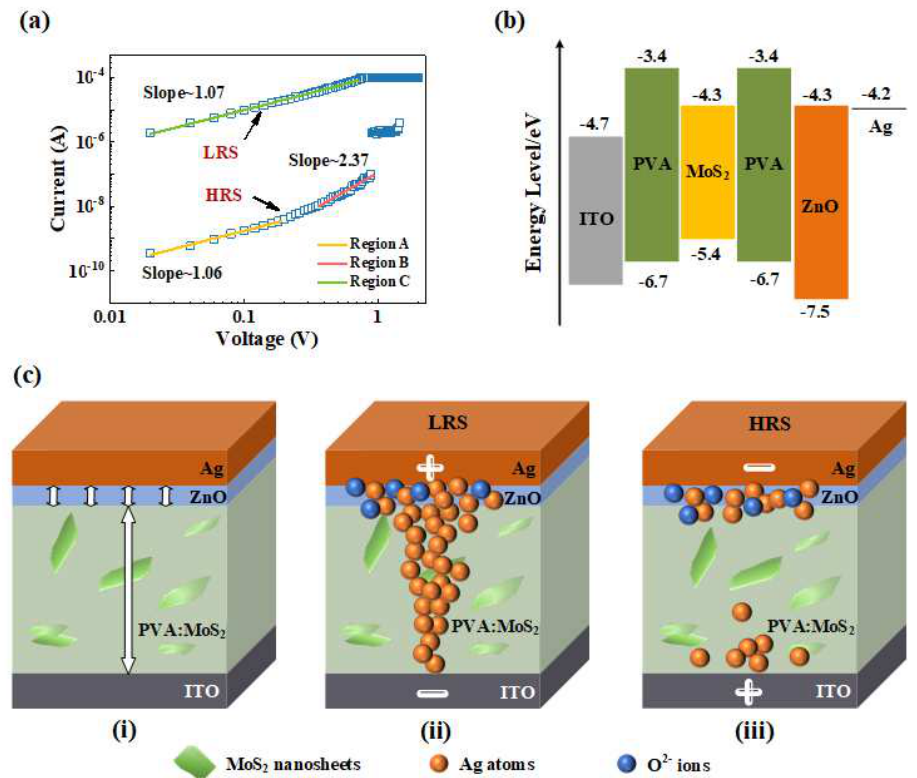
Figure 4. ( a ) I – V curve of the Ag/ZnO/PVA:MoS 2 /ITO memristor plotted in log-log scale, ( b ) Energy Figure 4. ( a ) I − V curve of the Ag/ZnO/PVA: MoS2/ITO memristor plotted in log-log scale, ( b ) Energy band diagram of Ag/ZnO/PVA: MoS2/ITO device structure, ( c ) Schematic presentation of resistive band diagram of Ag/ZnO/PVA:MoS 2 /ITO device structure, ( c ) Schematic presentation of resistive switching mechanism in Pristine ( i ), LRS ( ii ) and HRS ( iii ), respectively. switching mechanism in Pristine ( i ), LRS ( ii ) and HRS ( iii ),